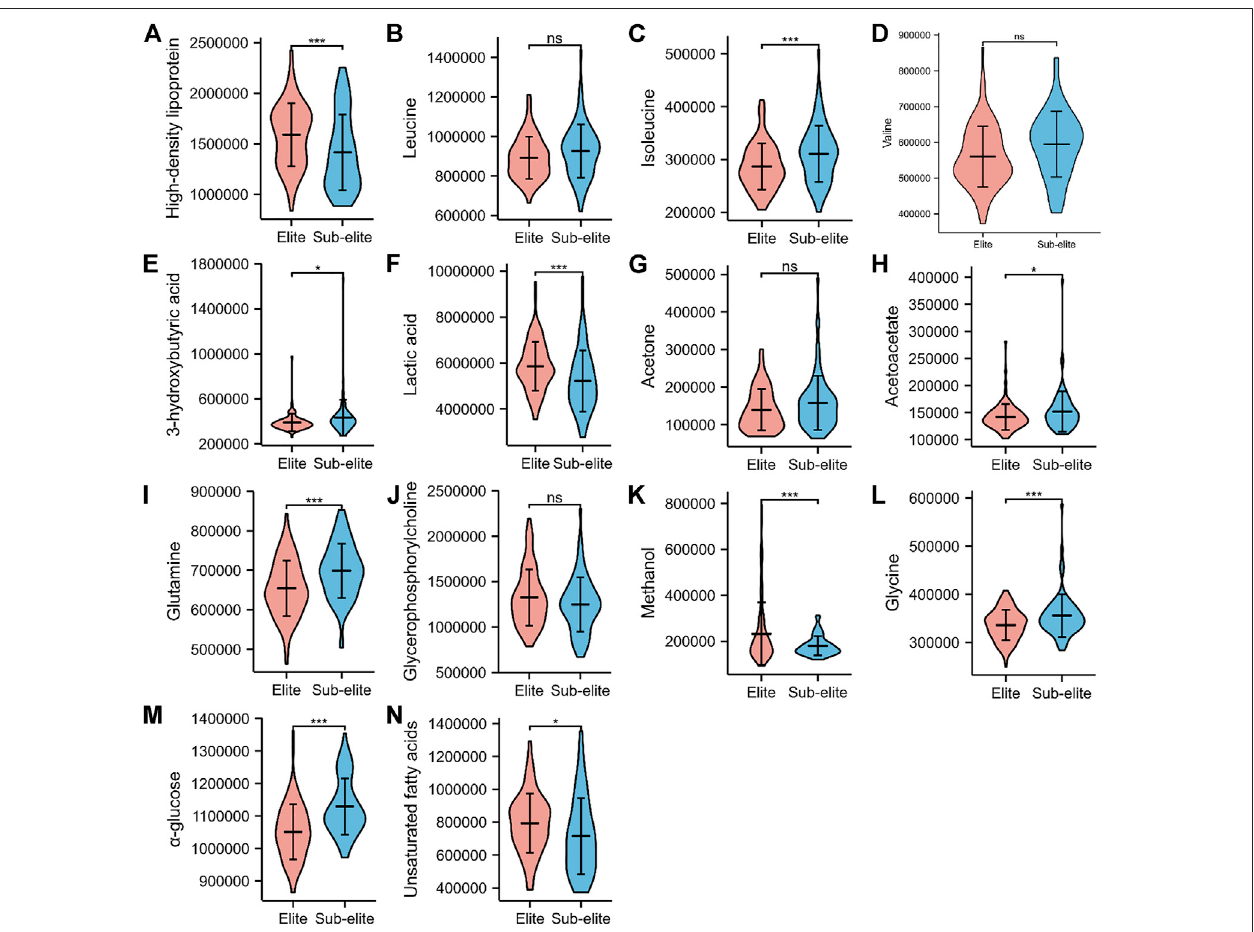
FIGURE2| Theviolinplotsofserummetaboliteswithsigni fi cantdifferencesbetweeneliteandsub-elitelevelswimmers. (A) ComparisonofHigh-densitylipoprotein between Elite and Sub-elite swimmers. (B) Comparison of Leucine between Elite and Sub-elite swimmers. (C) Comparison of Isoleucine between Elite and Sub-elite swimmers. (D) Comparison ofValine between Elite and Sub-elite swimmers. (E) Comparison of 3-Hydroxybutyric acid between Elite and Sub-elite swimmers. (F) Comparison of Lactic acid between Elite and Sub-elite swimmers. (G) Comparison of Acetone between Elite and Sub-elite swimmers. (H) Comparison of Acetoacetate between Elite and Sub-elite swimmers. (I) Comparison ofGlutamine between Elite and Sub-elite swimmers. (J) Comparison of Glycerophosphorylcholine between Elite and Sub-elite swimmers. (K) Comparison of Methanol between Elite and Sub-elite swimmers. (L) Comparison of Glycine between Elite and Sub-elite swimmers. (M) Comparison of α -glucose between Elite and Sub-elite swimmers. (N) Comparison of Unsaturated fatty acids between Elite and Sub-elite swimmers. *** p < 0.001, ** p < 0.01, * p < 0.05.